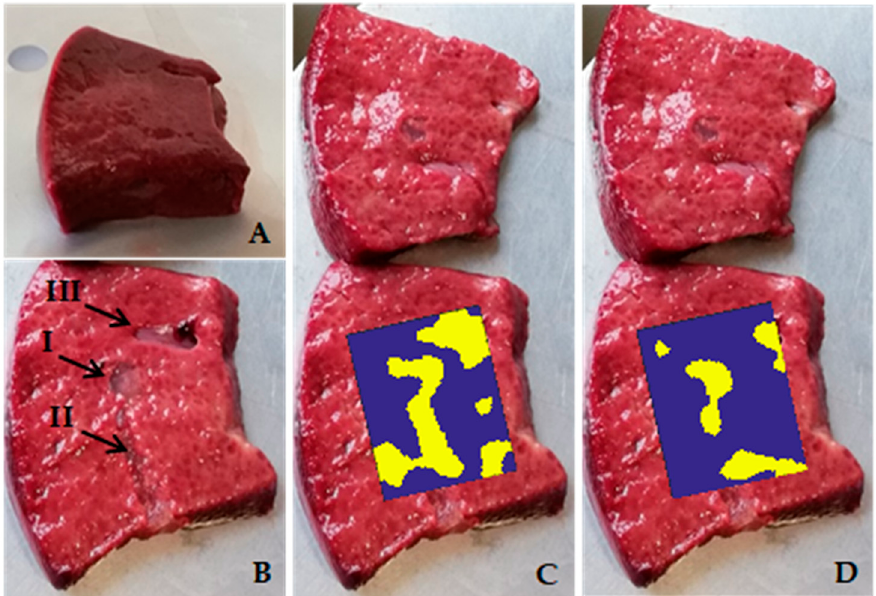
Figure 8. Analysis of the liver tissue sample #1. ( A ) picture of the liver sample with the agar inclusions inside. ( B ) One of the two slices of the sample #1 with marked inclusions of type I, type II and type III. ( C ) CIA and ( D ) CIS maps superimposed on the scanned area.